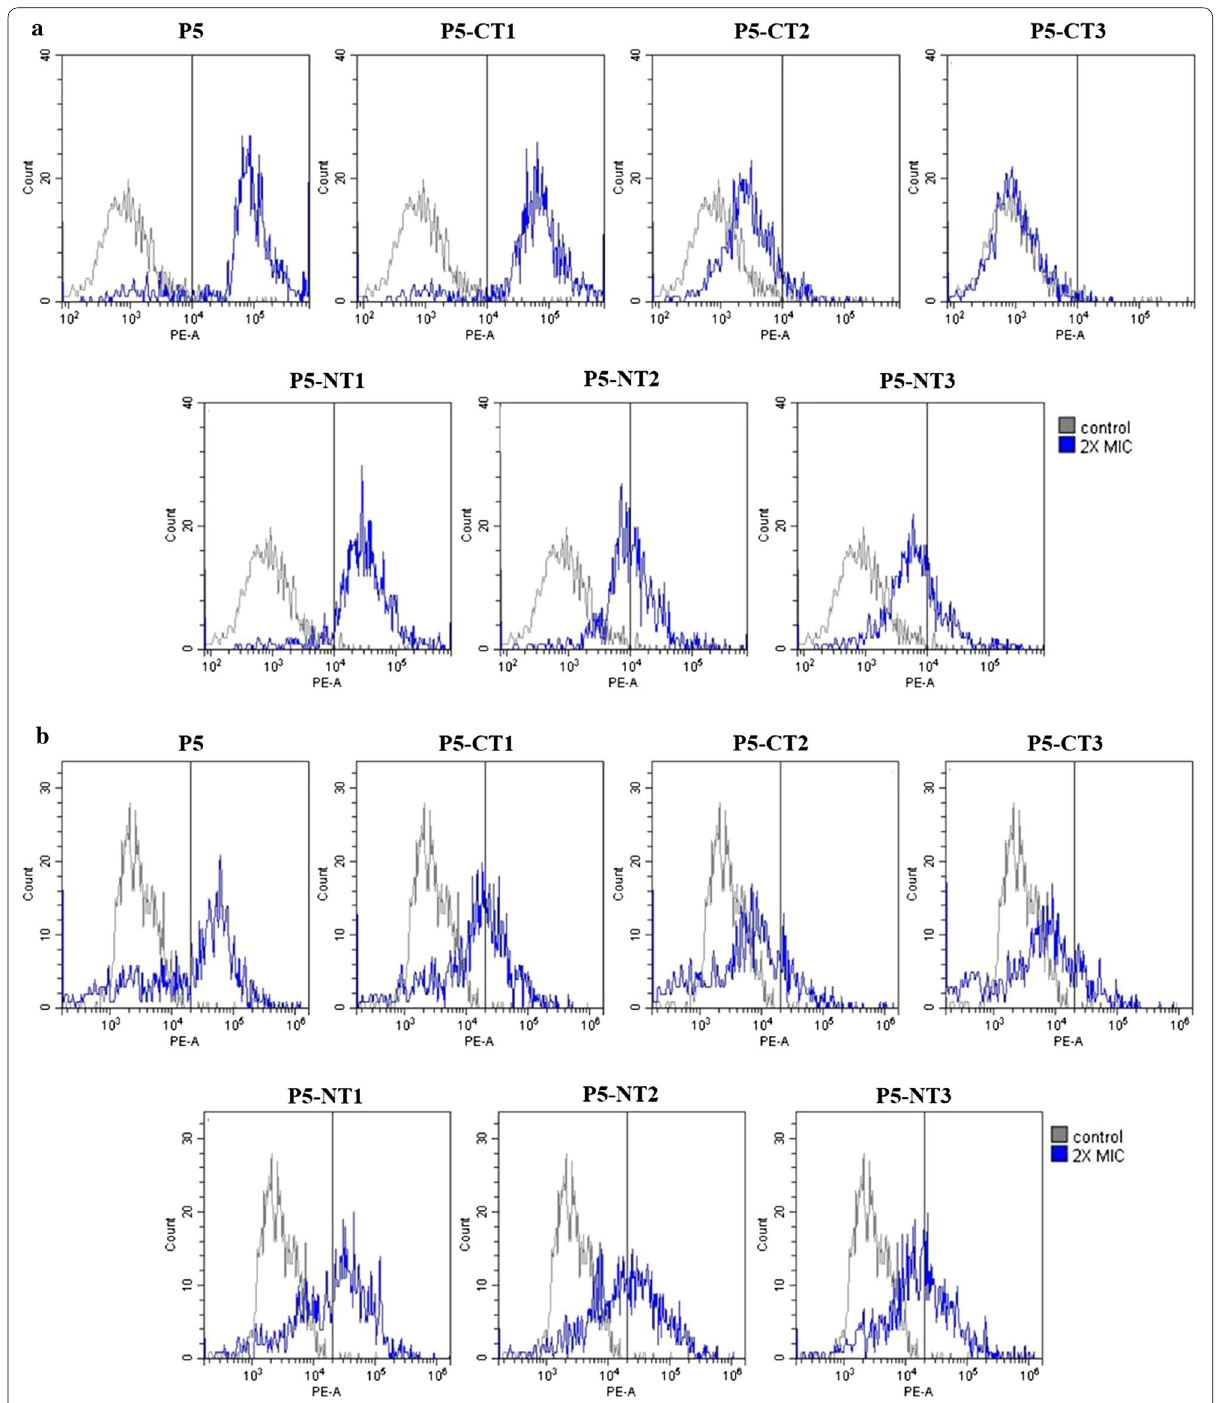
Fig. 7 Flow cytometry analysis. Exponential phase P. aeruginosa ATCC 27853 and S. aureus ATCC 25923 were treated with the peptides, and PI was analyzed by fluorescence activated cell sorting (FACS) flow cytometry. a P. aeruginosa ATCC 27853, b S. aureus ATCC 25923. PI propidium iodide, MIC minimum inhibitory concentration, NPN n -phenyl-1-naphthylamine, CT C-terminus, NT